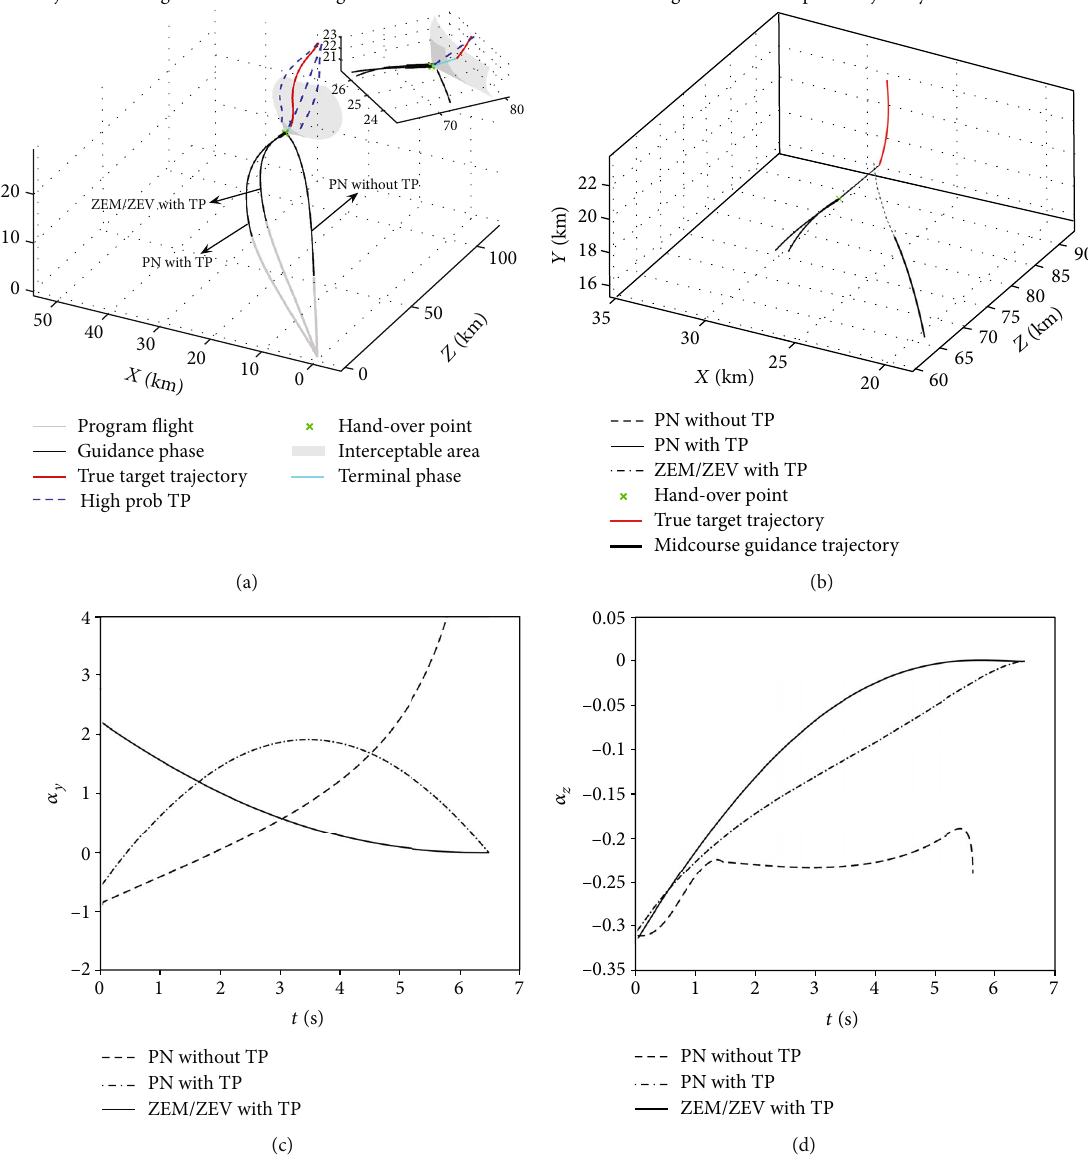
Figure 8: Comparison of results considering predictions of trajectories of NSGVs under PN and the proposed guidance methods. (a) Trajectories of interception using di ff erent midcourse guidance methods. (b) Trajectories of interception during terminal guidance phase using di ff erent midcourse guidance methods. (c) Normal overload change curve during terminal guidance phase. (d) Lateral overload change curve during terminal guidance